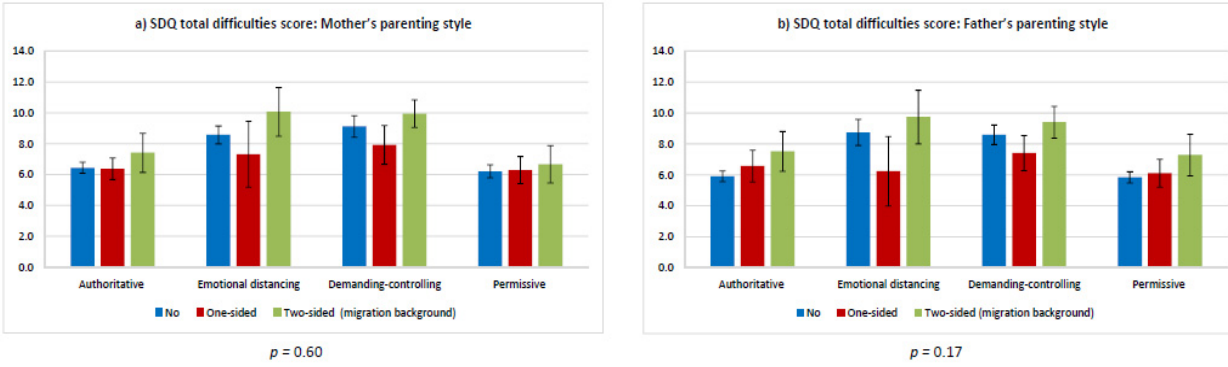
Figure 2. Predicted mean Strengths and Difficulties Questionnaire total difficulties scores stratified by parenting style and migration background (with 95% confidence intervals and p -values (joint Wald test)). ( a ) SDQ total difficulties scores: Mother’s parenting style. ( b ) SDQ total difficulties scores: Father’s parenting style.